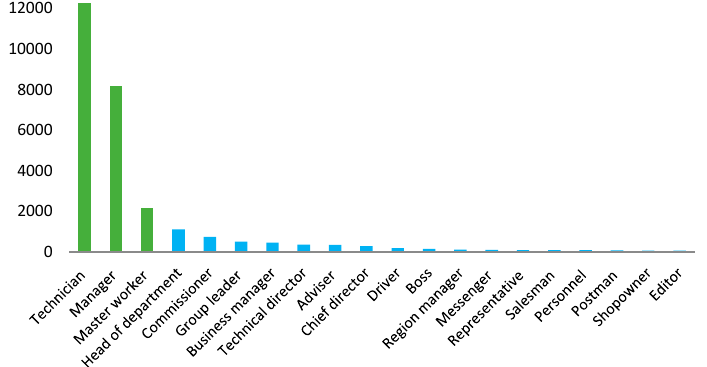
Figure 8. Statistical results of job noun frequency in the natural texts of complaint handling results.